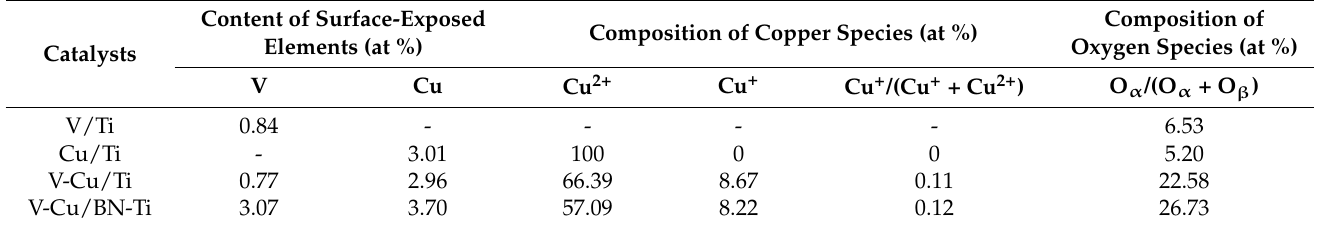
Table 1. Content of surface-exposed elements and valence states of elements and ratios of the synthesized